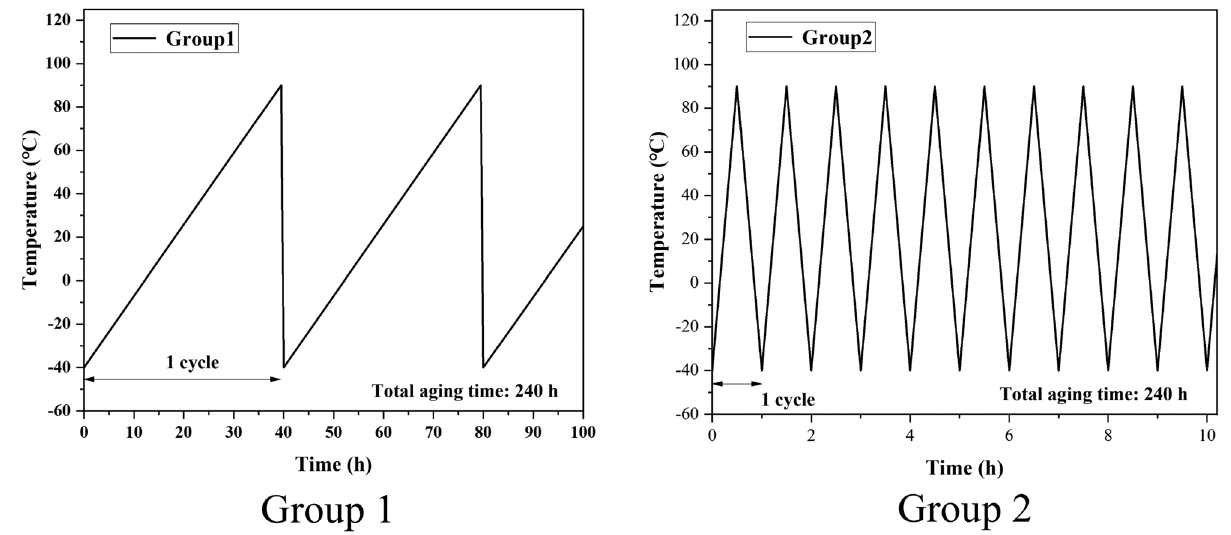
Figure 2: Temperature cycle control aging experiment -